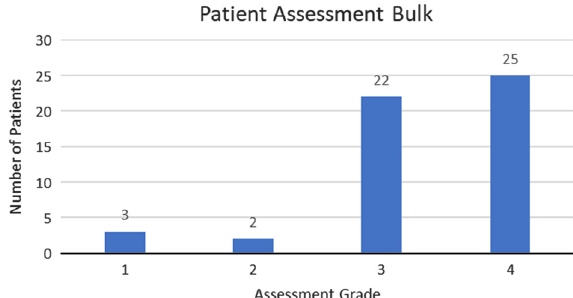
Figure 7. Patient assessment